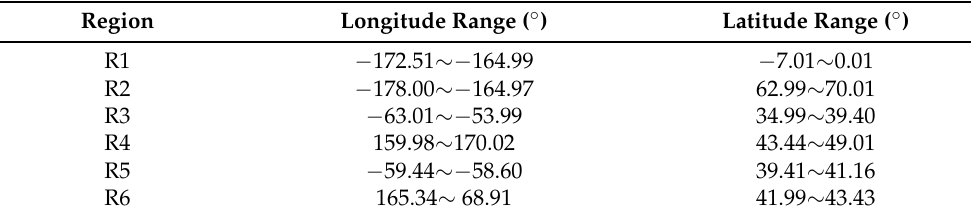
Table 2. Research Areas.